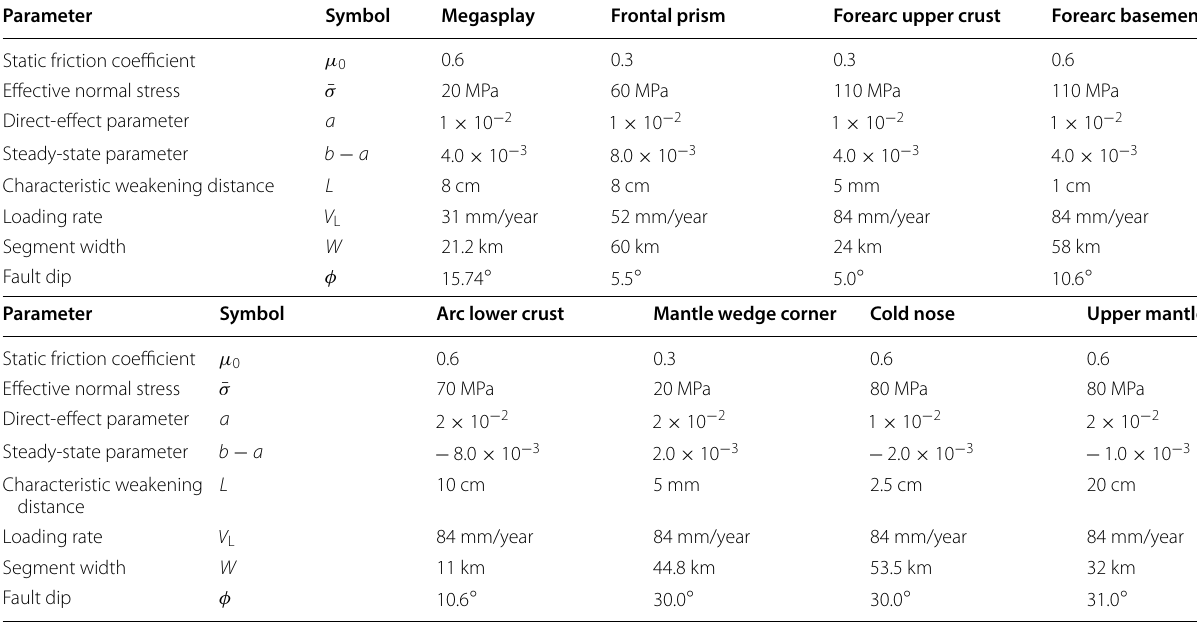
The model assumes uniform elastic properties with a shear modulus of G = 30 GPa, Poisson’s ratio ν = 0.25 , and shear wave speed V S = 3 × 10 3 m/s. The reference slip velocity is V 0 = 10 − 6 m/s